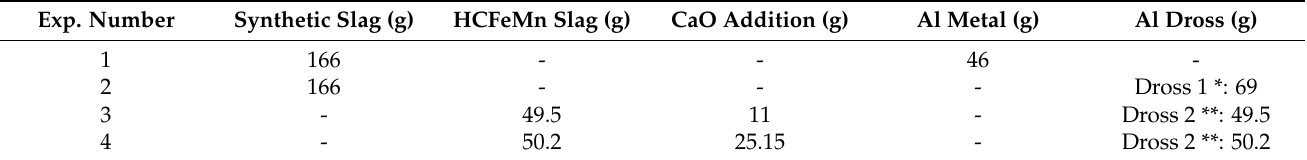
Table 1. The charge mixture details.